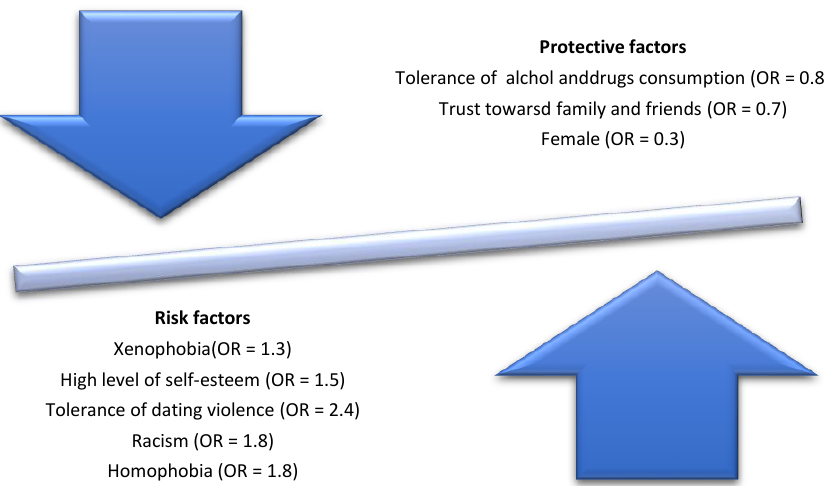
Figure 1. Risk and protection factors linked to bullying and cyberbullying as result of a binary logistic regression